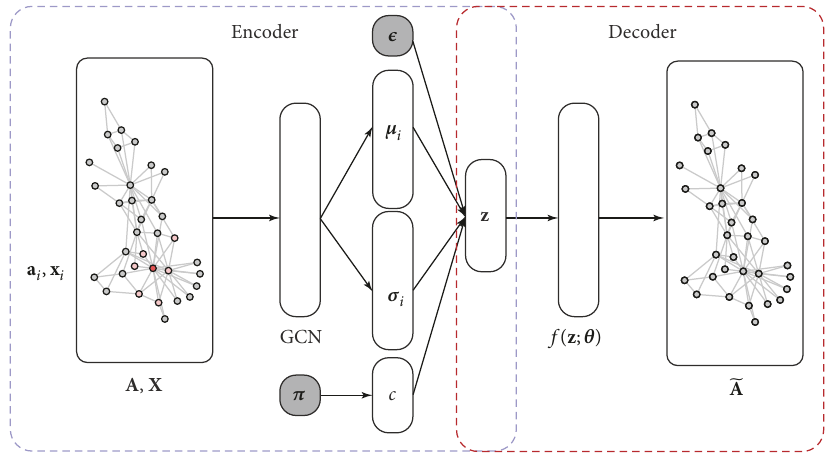
Figure 1: Conceptual illustration of Variational Graph Autoencoder Framework for Community Detection (VGAECD). In the encoding phase, VGAECD first convolves on the network, learning structural and nodal features in the process. These pieces of information are then mapped into a latent representation, 𝜇 𝑐 | 𝑖 and 𝜎 𝑐 | 𝑖 which are parameters to Mixture of Gaussian Model. Subsequently, we can then sample ̃ A can be reconstructed using a decoding function, 𝑓(⋅) . The loss is calculated and to obtain a latent representation for each node z . Finally, backpropagated to the latent variables.